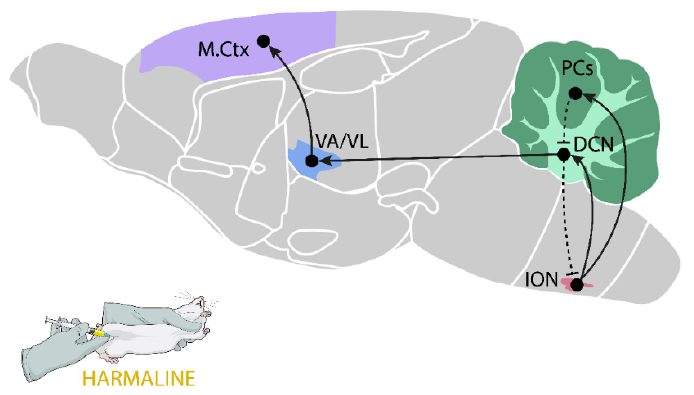
Figure 1. Neural circuits involved in the generation and spread of harmaline-induced tremor in rats. Description in the text. Solid lines: glutamatergic pathways, dashed lines: GABAergic pathways, DCN: deep cerebellar nuclei, ION: inferior olive nuclei, M.Ctx: motor cortex, PCs: Purkinje cells, VA/VL: ventroanterior/ventrolateral thalamic nuclei.